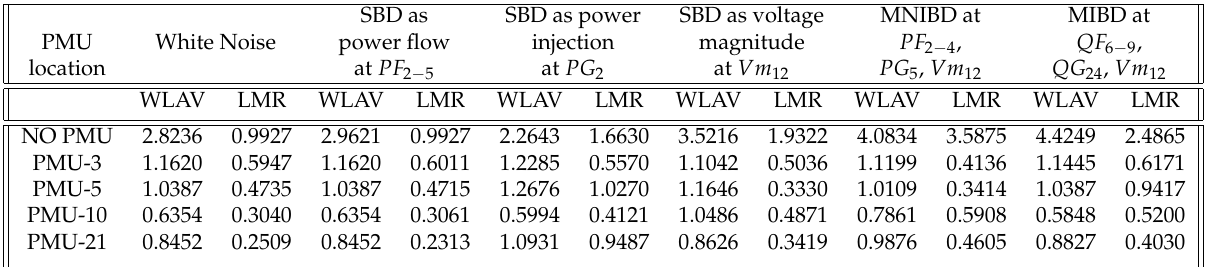
Table 7. IEEE 30 Bus - Absolute voltage angle (AVA) error